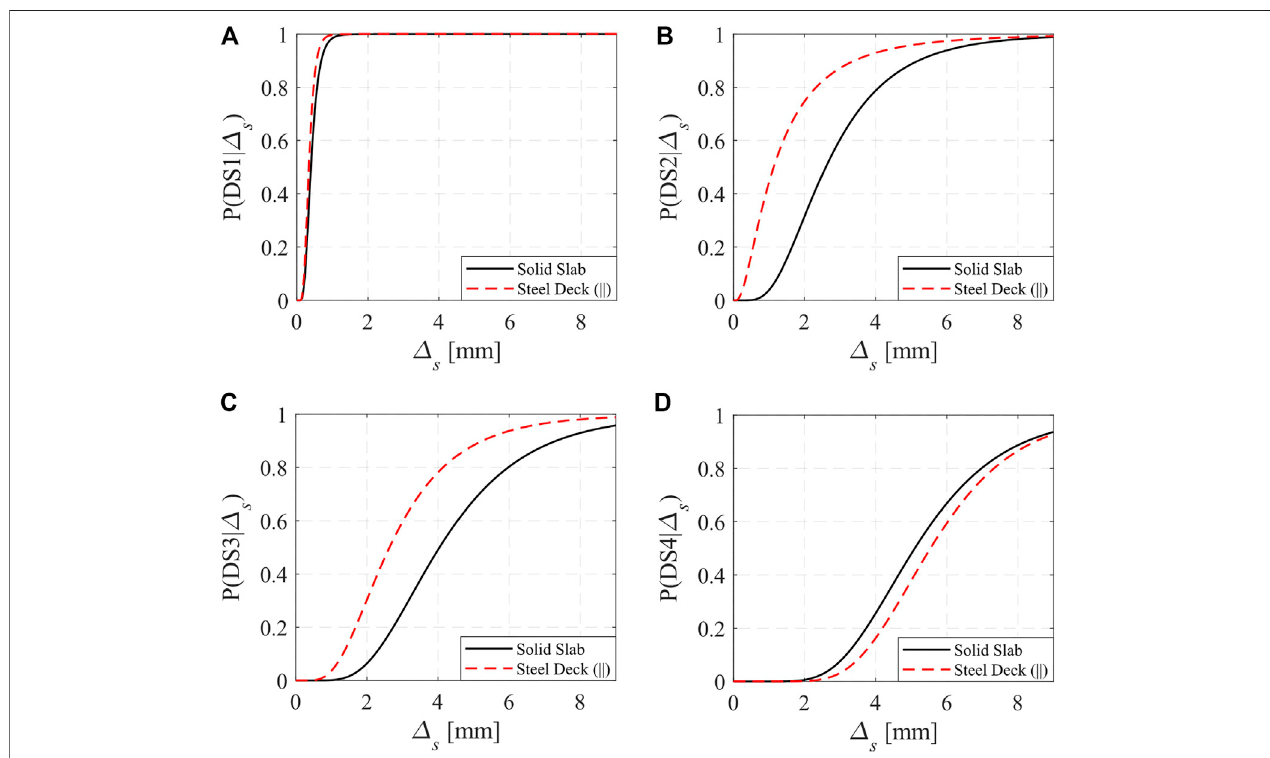
FIGURE 8 | Comparison between fragility functions of steel beam-slab connections derived for solid slabs and those derived for slabs consisting of a steel deck with ribs parallel to the steel beam. (A) DS1 (B) DS2 (C) DS3 and (D) DS4.